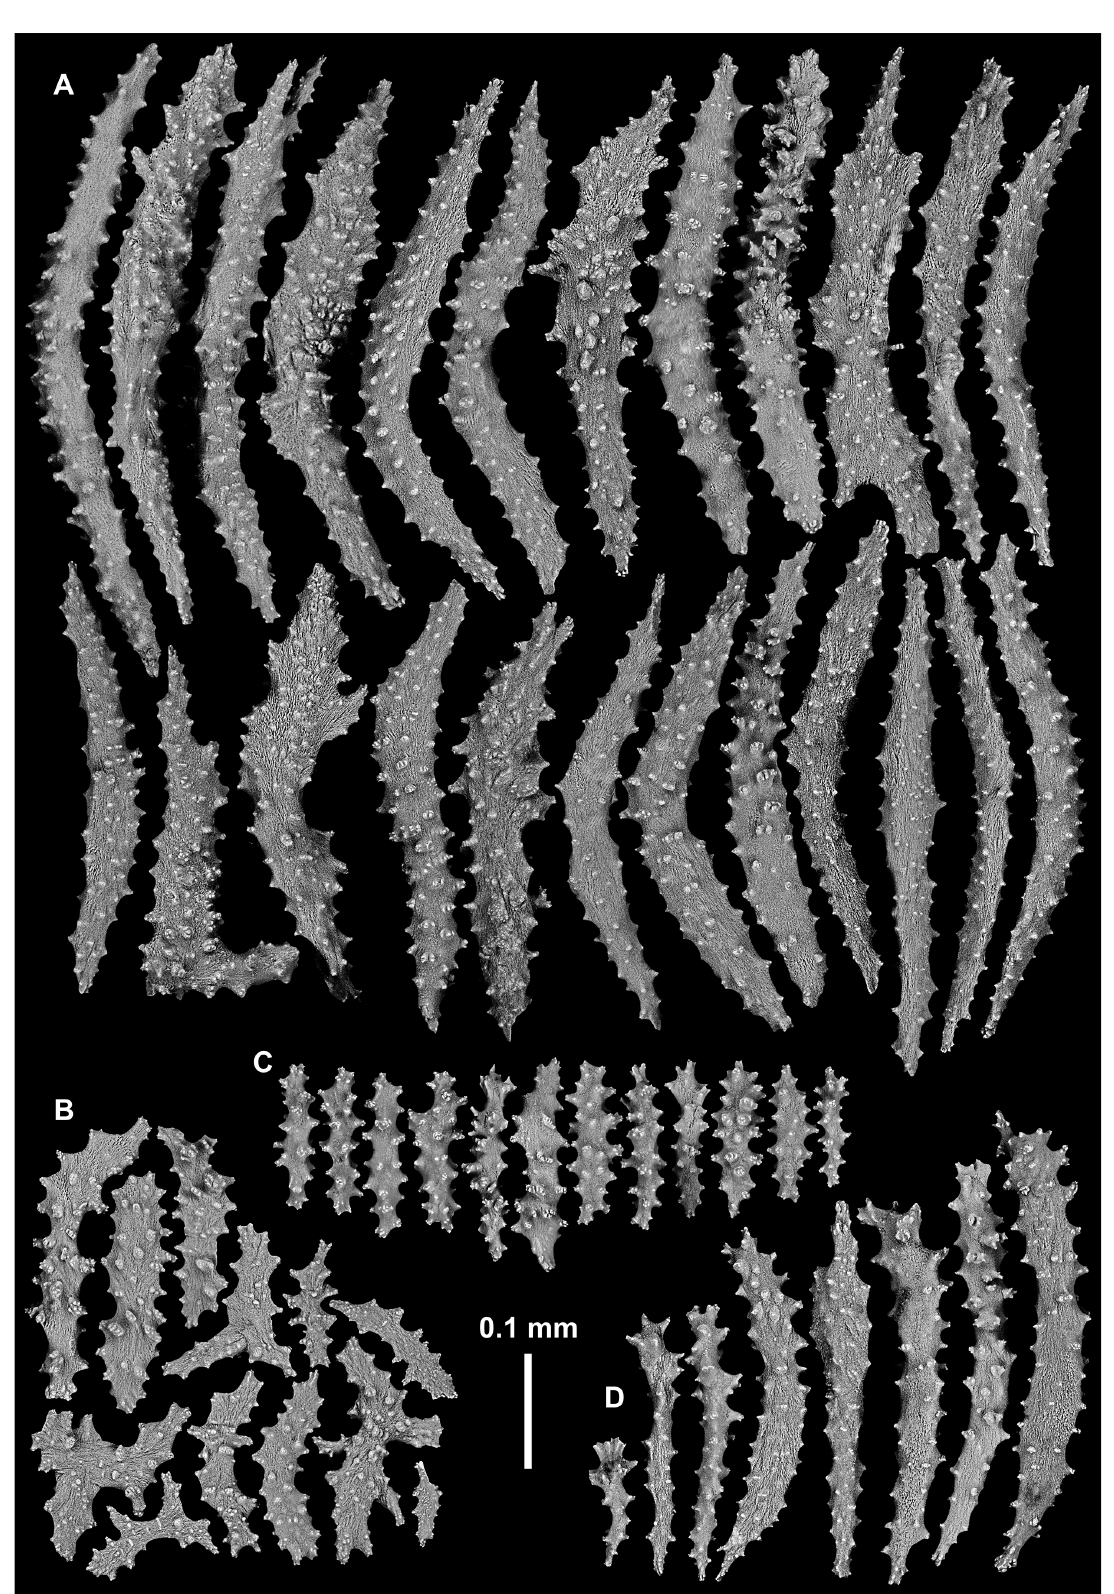
Fig. 35. Ushanaia solida gen. et sp. nov., holotype (NIWA 102133), SEMs of sclerites. A . Collaret and points. B . Tentacles. C . Polyp neck. D . Distal